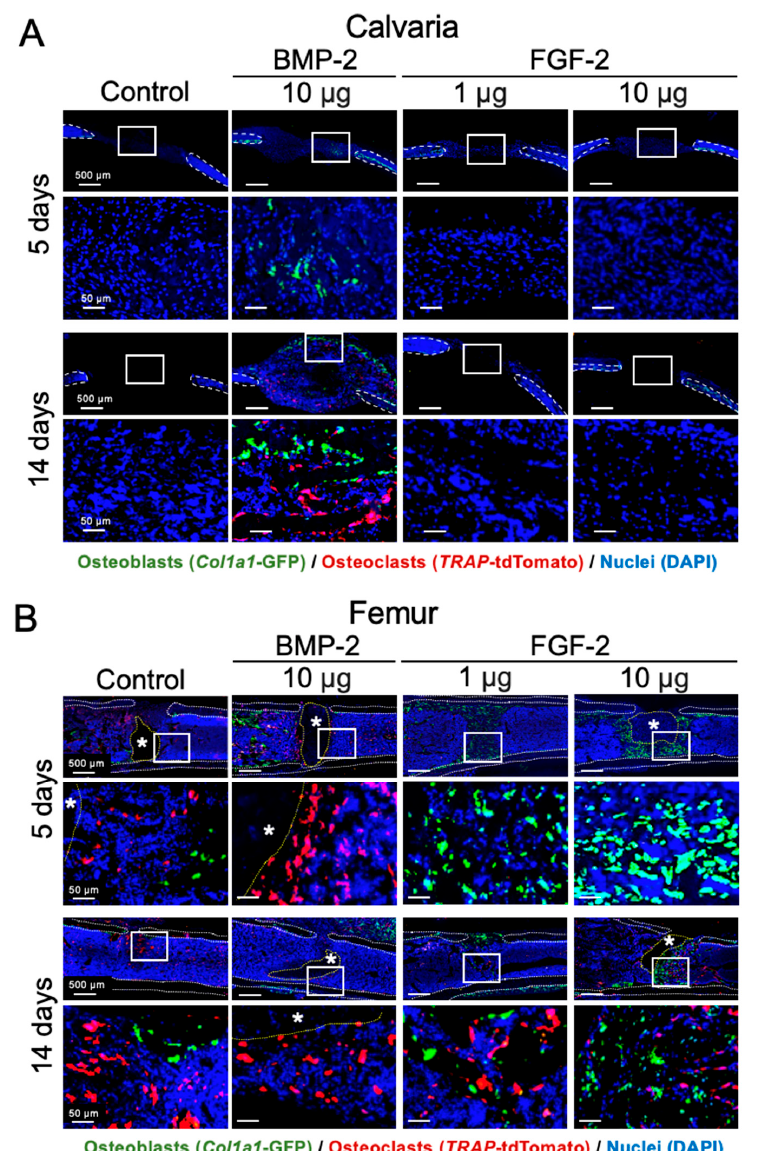
Figure 4. E ff ects of BMP-2 and FGF-2 on osteoblast and osteoclast in mouse calvarial and femoral defect. Cross-sectional frozen sections of calvaria (frontal plane, A ) and femurs ( B ) obtained from Col1a1 (2.3)-GFP / Trap -tdTomato mice after 5 and 14 days of collagen pellet implantation. GFP-positive osteoblasts and tdTomato-positive osteoclasts are shown in green and red, respectively. Dashed lines indicate the cortical bone (white) and the remained collagen pellet (*, yellow). Nuclei were stained with DAPI (blue). The results are representative of at least three independent